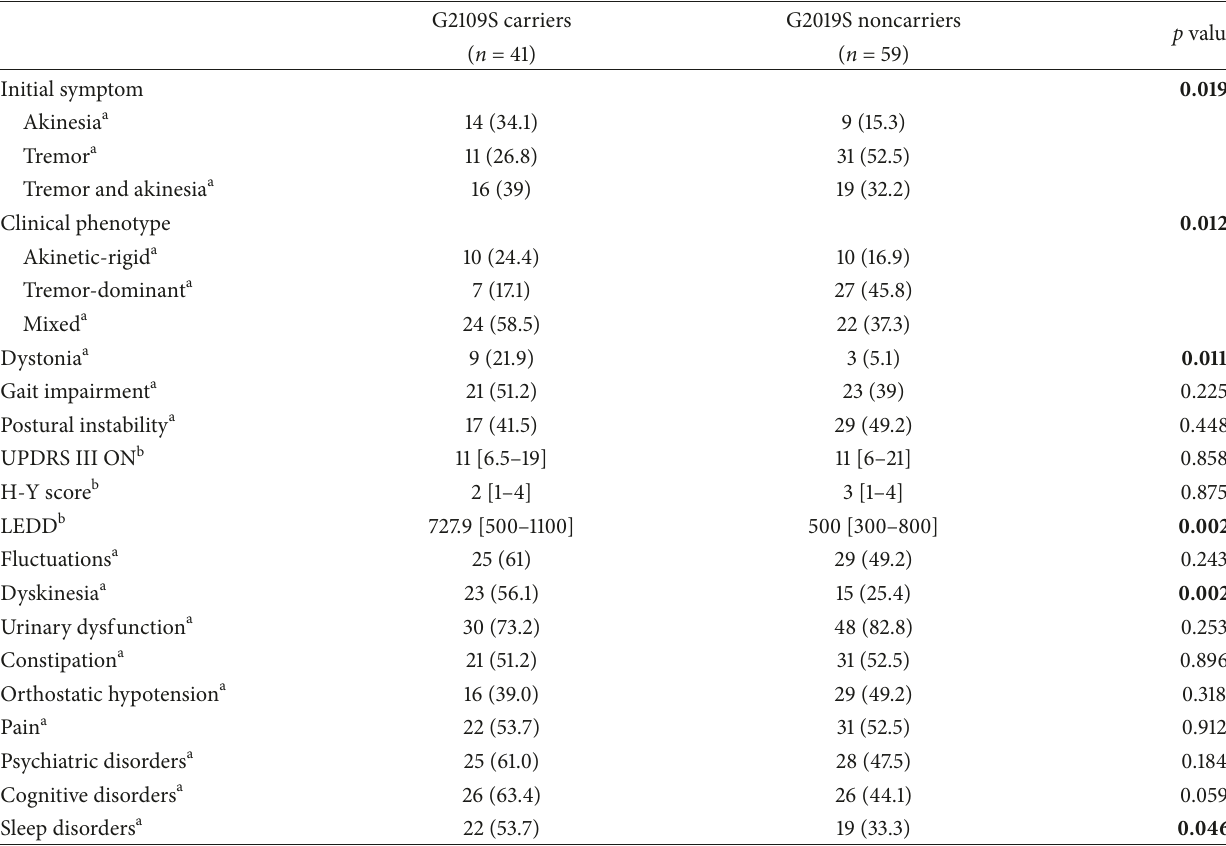
Table 3: Clinical features of G2019S carrier and noncarrier patients.